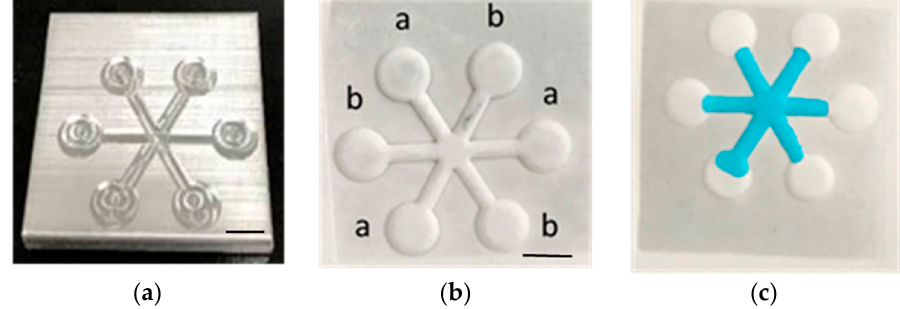
Figure 2. ( a ) The metalic mold for the microembossing process. ( b ) The embossed filter apper. ( c ) The channels with ink wicking through. Scale bar: 4 mm.